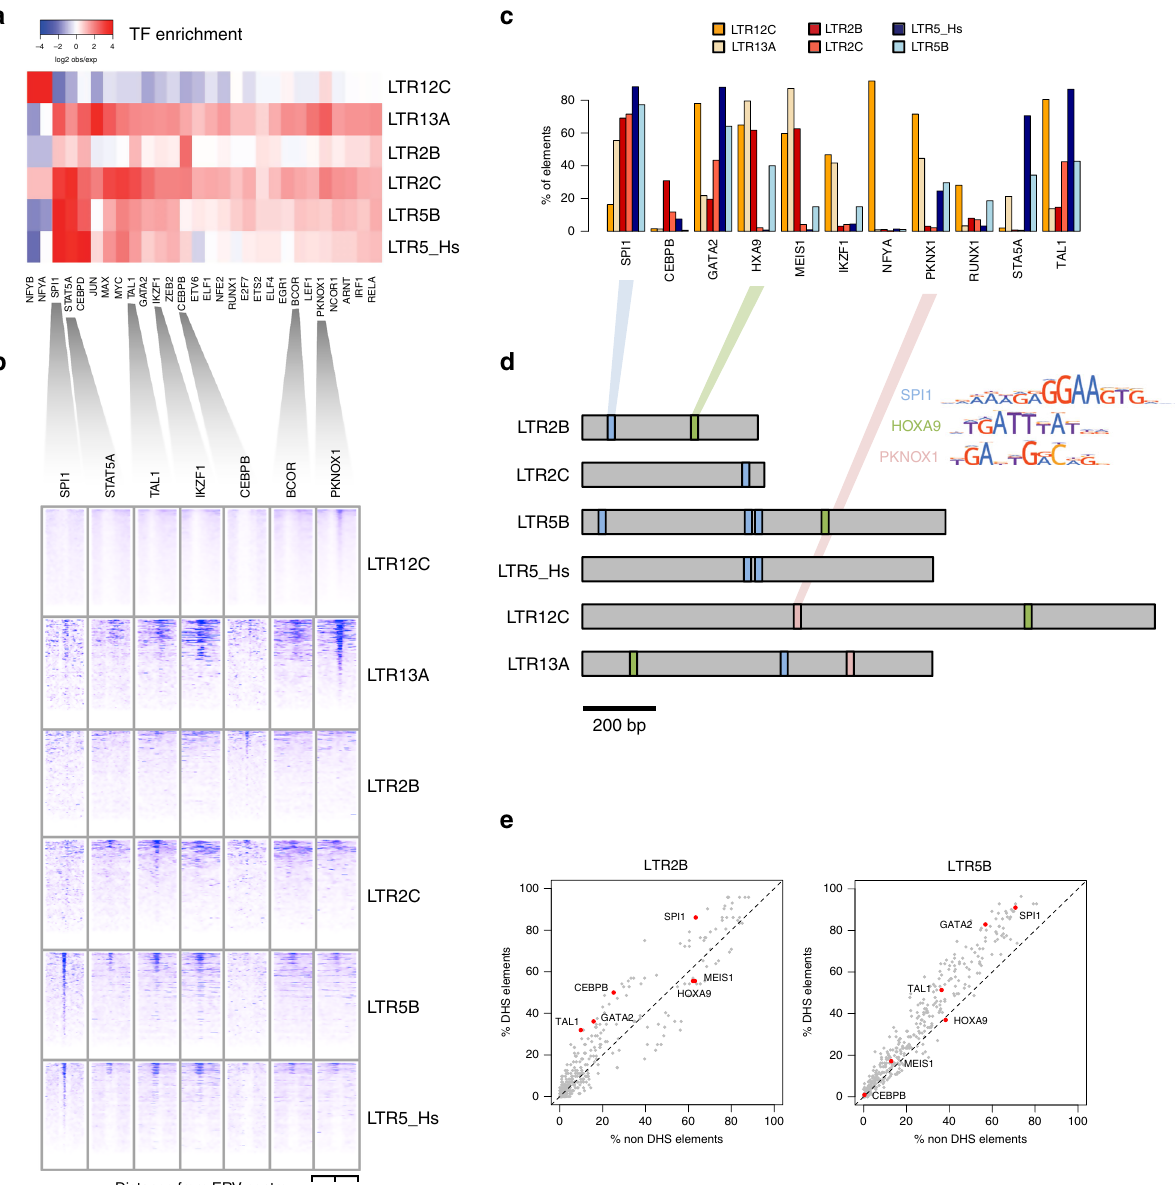
Fig. 3 A-DARs bind AML-related transcription factors (TFs). a Heatmap of the observed/expected enrichment for TF-binding sites in K562 cells. b ChIP- seq pro fi les of selected TFs across all elements of each A-DAR family. For each family, elements are displayed in the same order across all TF pro fi les. c Percentage of ERVs from each family bearing a binding motif for the indicated TFs. d Location of selected TF motifs at the consensus sequences of each A-DAR family. e TF motif frequency at LTR2B and LTR5B elements, comparing those that overlap DHSs with those that do